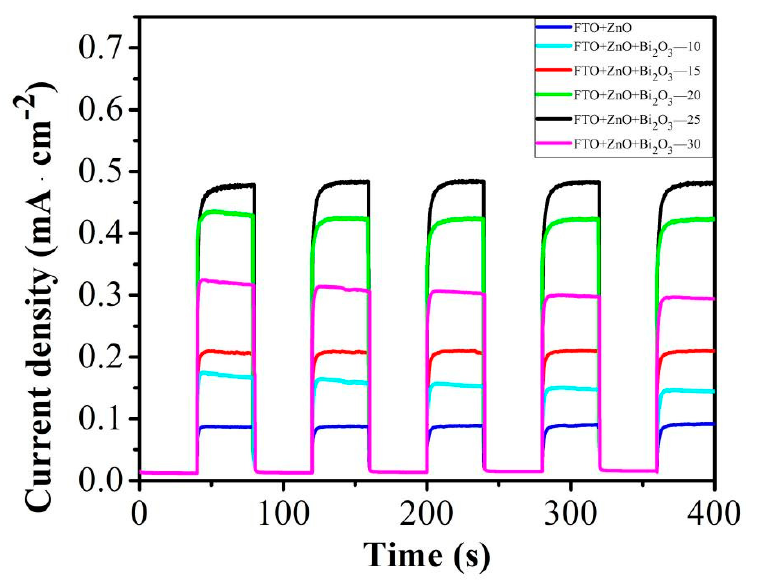
Figure 6. J-V image of a sample measured by an electrochemical workstation using a xenon lamp to simulate sunlight exposure.